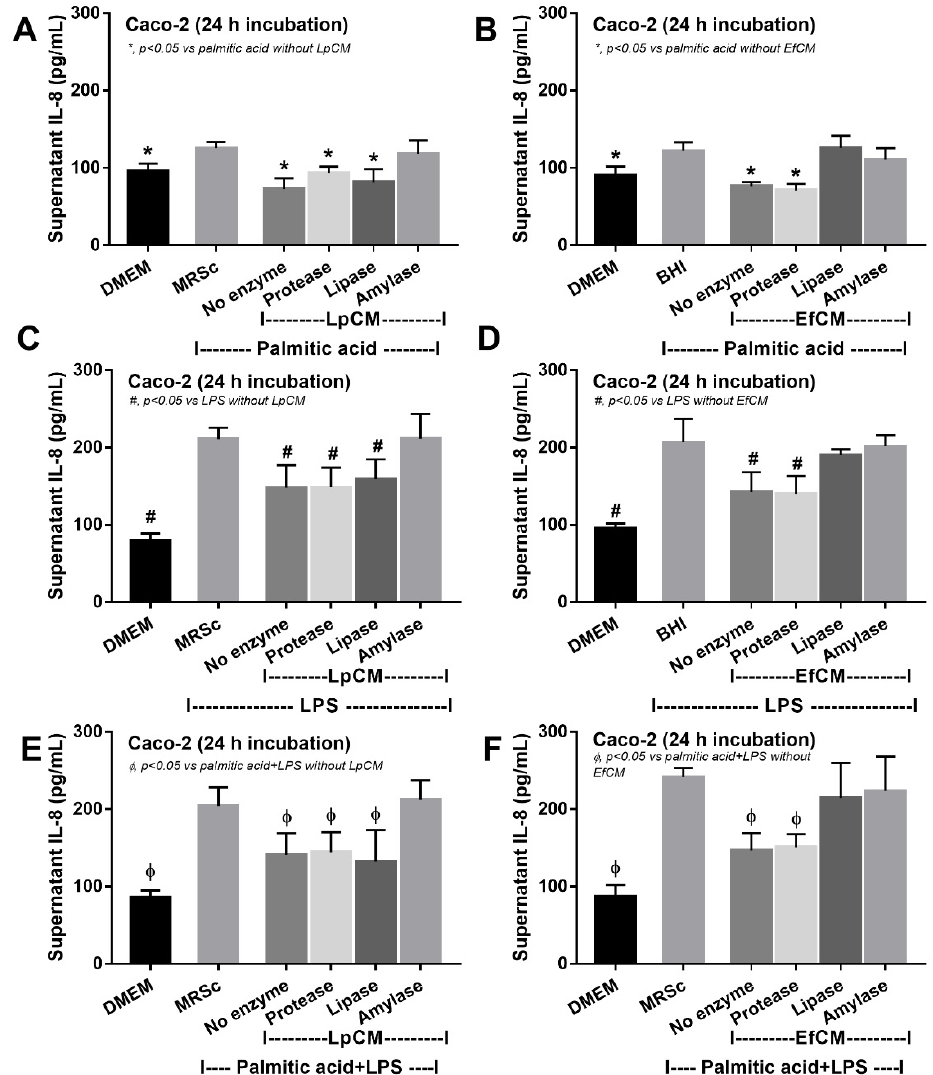
Figure 5. Supernatant IL-8 from Caco-2 cells (enterocytes) with Dulbecco’s Modified Eagle Medium (DMEM; media for Caco2 cell) or probiotic condition media from Lactiplantibacillus plantarum (LpCM) or Enterococcus faecium (EfCM) after incubated with or without enzyme inactivation (protease, lipase and amylase) when activated by 0.5 mM palmitic acid ( A , B ), 100 ng/mL of lipopolysaccharide (LPS) ( C , D ) or palmitic acid with LPS ( E , F ) are demonstrated. Notably, MRSc (De Man, Rogosa and Sharpe broth) and) and BHI (Brain Heart Infusion broth) were the culture media for Lp and Ef, respectively, and independent triplicate experiments were performed for all experiments.